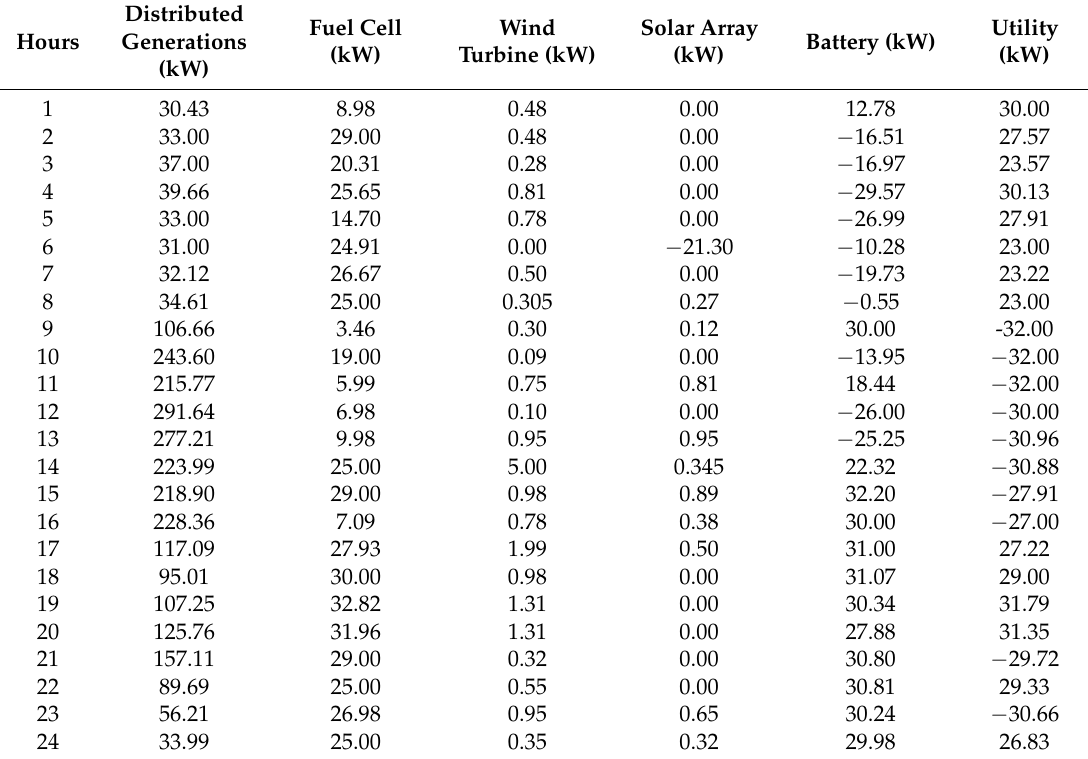
Table 4. Operation cost optimization of different energy generating units without